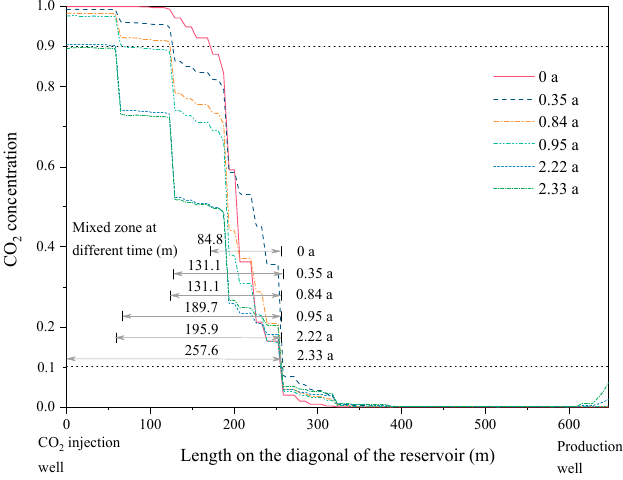
Figure 11. The CO 2 concentration in the diagonal of the reservoir for the UGSR with 20% CO 2 .